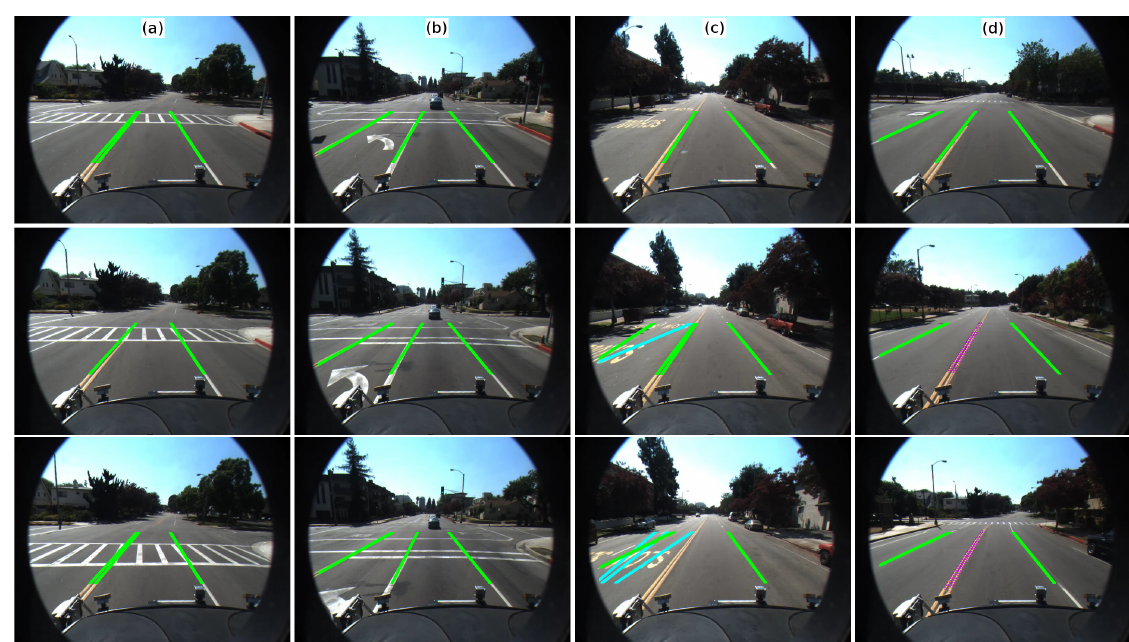
Figure 13. Lane marking evaluation using Caltech dataset. ( a ) shows the result of the proposed method in the presence of crosswalk areas; ( b ) shows the result for the case of stop lines and arrow; ( c ) shows the result of the wrong detection due to the text on the road; and ( d ) shows the error in detection given by double lane marking. It happens because of the clustering label both on the same cluster, due to the gap between the lane